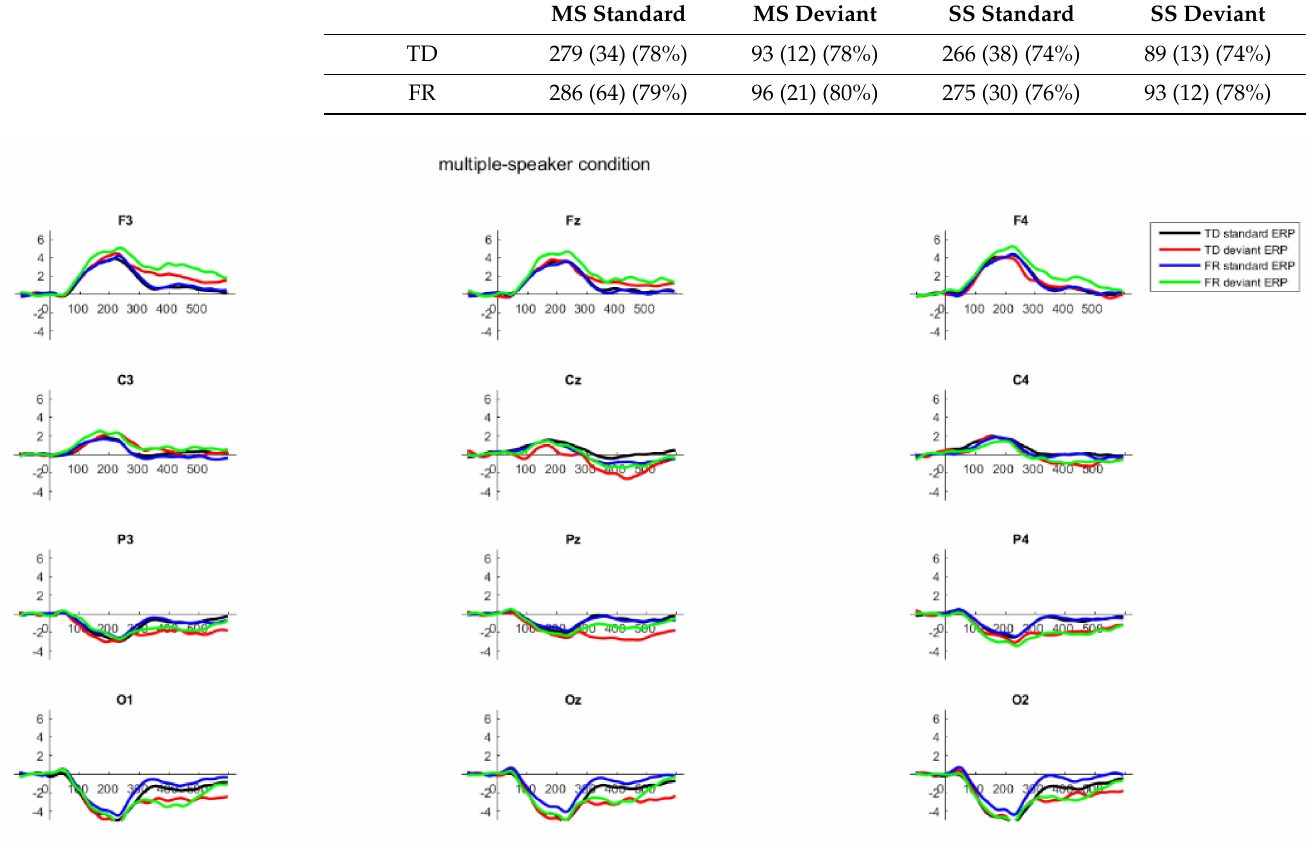
Table 3. TD and FR mean (SD) (percentage of total trials) accepted trials in the multiple-speaker (MS) and single-speaker (SS) condition.